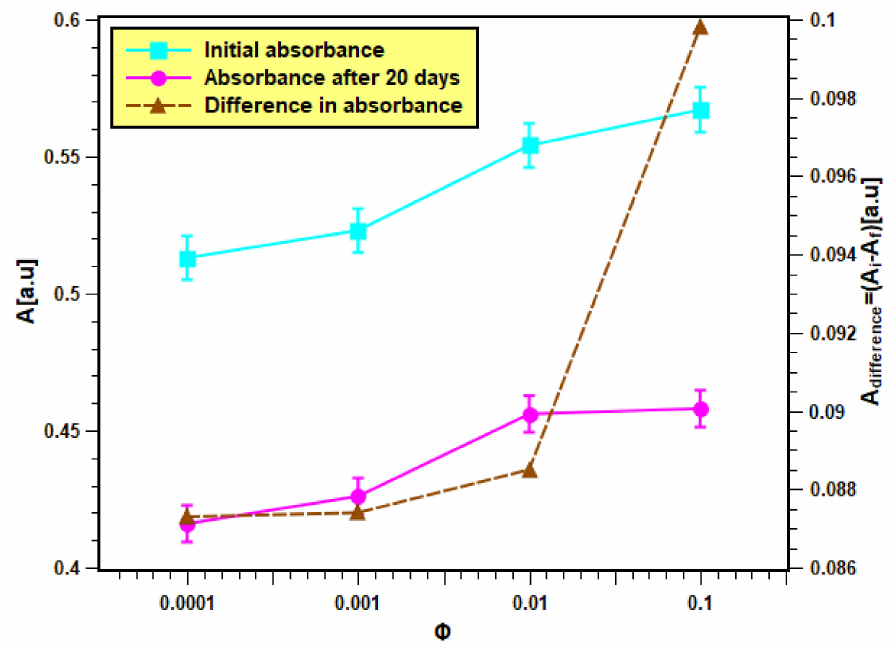
Figure 7. Light absorbance result of the as-prepared nanofluid